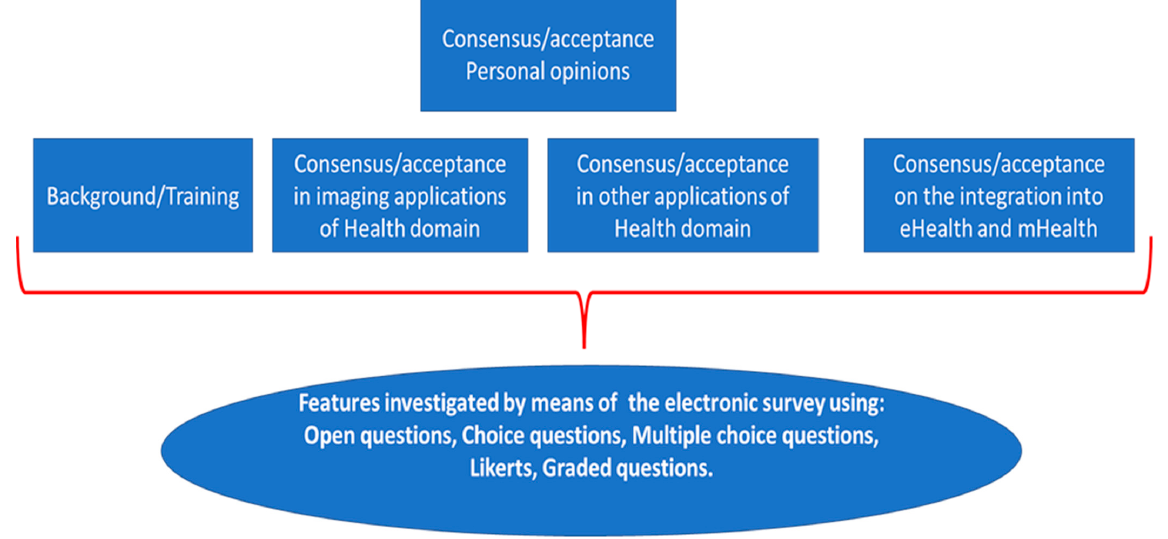
Figure 3. Features investigated by means of the electronic survey.